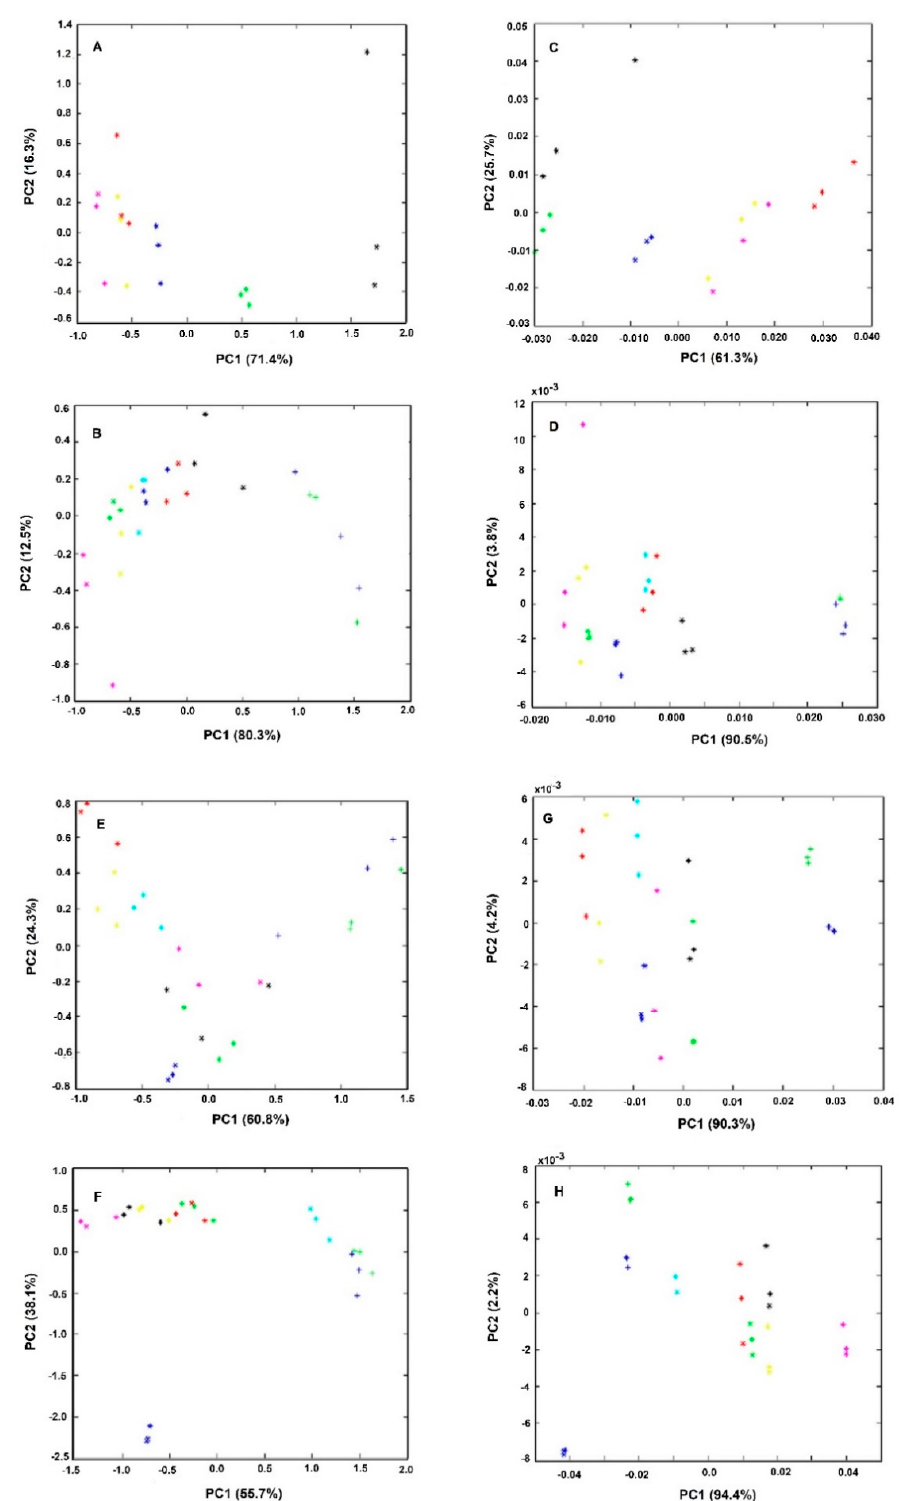
Figure 3. PCA of triplicates of bacteria spectra obtained from experiments as described in Table 1. All spectra were pre-processed by off-set and MSC correction. The graphs on the right ( E – H ) were further preprocessed by the first spectral derivative in relation to the respective left graphs ( A – D ). Legend of symbols: Blue—0 mg/L; Green—2.5 mg/L; Magenta—5 mg/L; Yellow—25 mg/L; Red—50 mg/L; Black—75 mg/L; Cyan—100 mg/L; Blue-cross—200 mg/L; Green (cross)—400 mg/L.